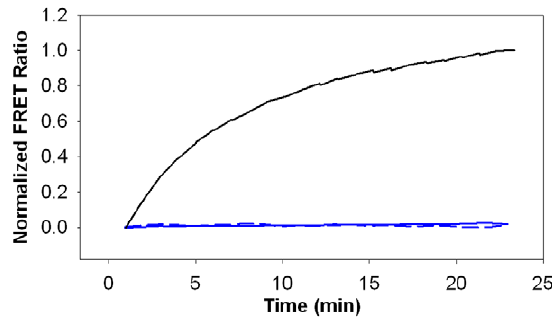
Figure 8. FRET kinetic assay for cisplatin binding to CMG2 and PA. Fluorescently labeled CMG2 R40 . C C178A*AF546 (1 m M) was preincu- bated with vehicle alone (DMSO) for 30 minutes before being rapidly diluted into PA E733C*AF488 to a final concentration of 10 nM of both proteins and the acceptor/donor fluorescence ratio was recorded over time (black line). Similarly, fluorescently labeled CMG2 was also preincubated with 500 m M cisplatin for 30 minutes before being rapidly diluted into PA as in the vehicle control. Fluorescence was again recorded over time (solid blue line). Fluorescent PA (1 m M) was also preincubated with 500 m M cisplatin for 30 minutes before being rapidly diluted into a solution of labeled CMG2. Fluorescence was recorded over time (dashed blue line). Excitation was 485